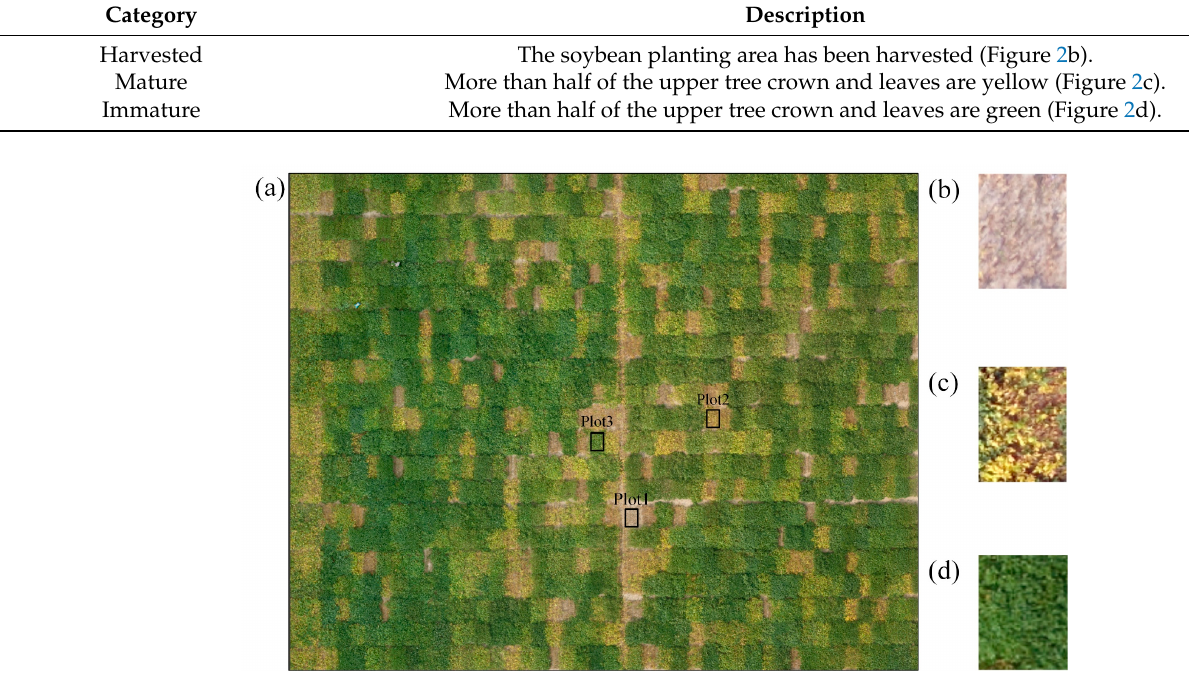
Figure 2. Maturity information: ( a ) P3-RGB; ( b ) mature region; ( c ) immature region; ( d ) harvested region. Note: Plot1, Plot2, and Plot3 in ( a ) correspond to ( b , c ), and ( d ), respectively.